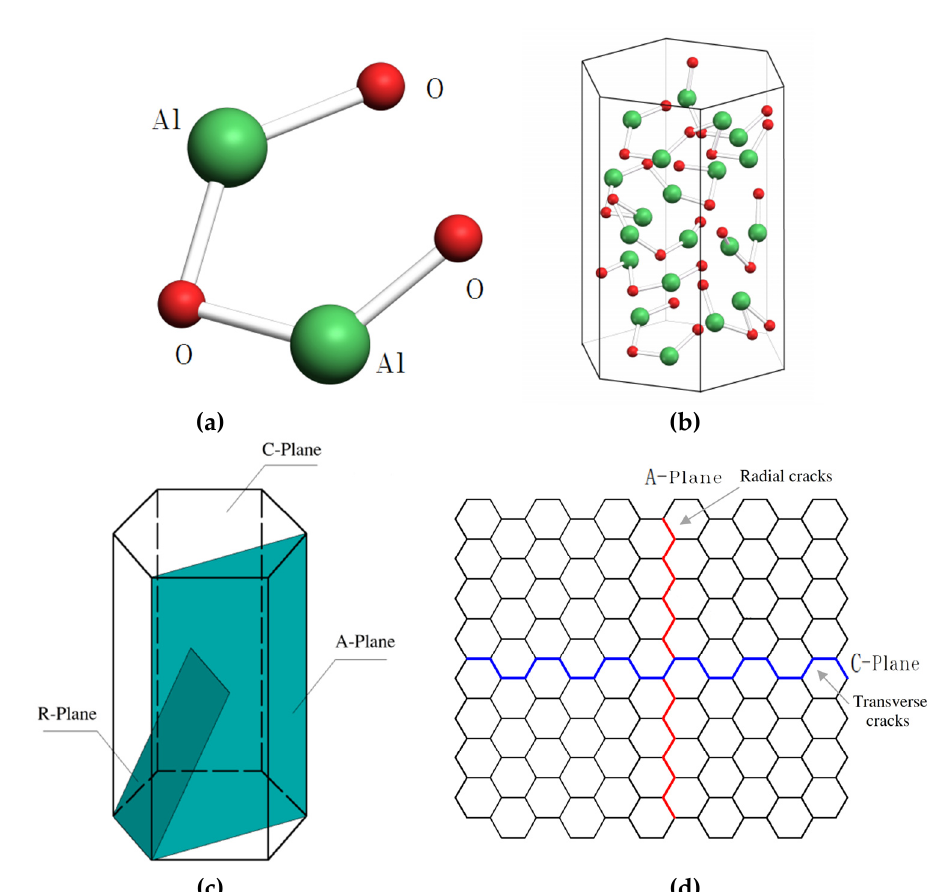
Figure 1. Structure of sapphire material. ( a ) Al 2 O 3 covalent bonding. ( b ) Sapphire crystal structure. ( c ) Cutting surface of sapphire material. ( d ) Cutting schematic diagram.